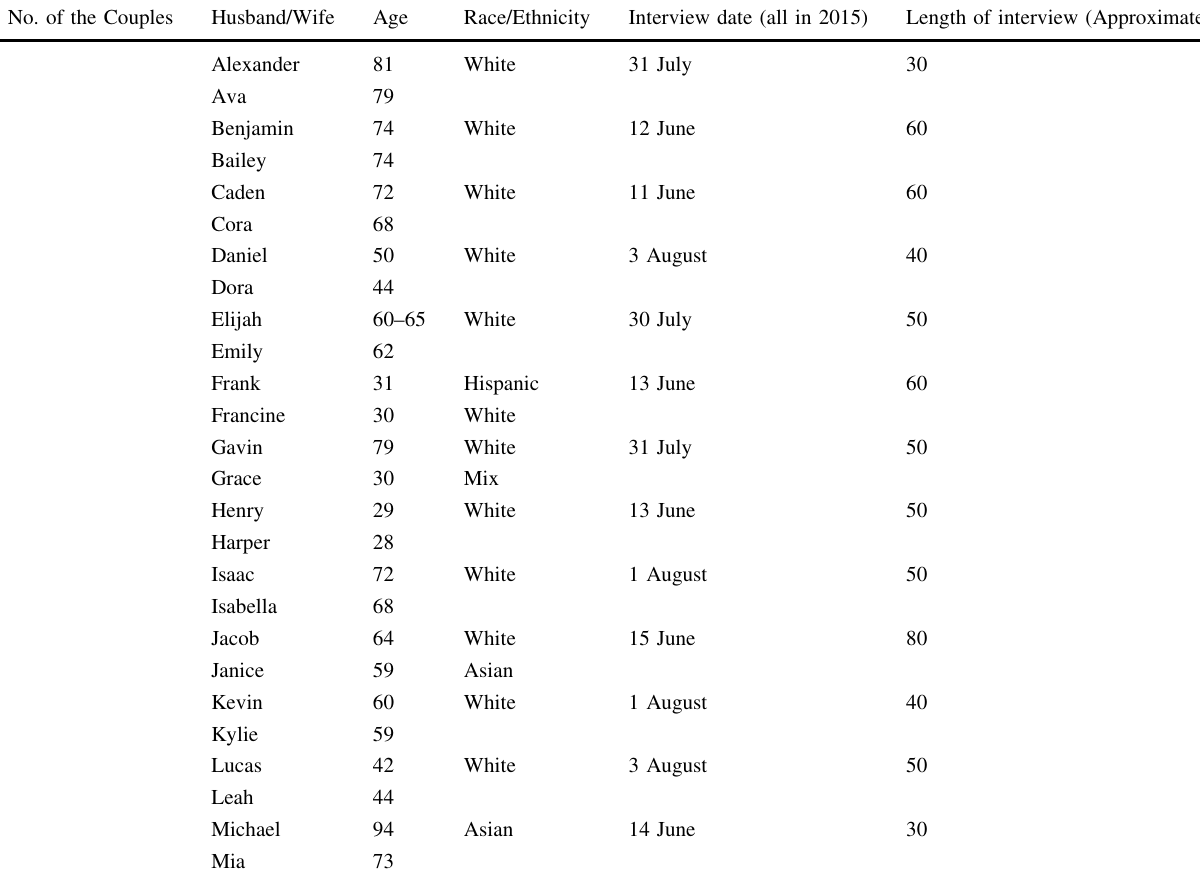
Table 3 Characteristics of the couples interviewed about household hurricane preparedness in Sarasota County, Florida, 2015 ID No. of the